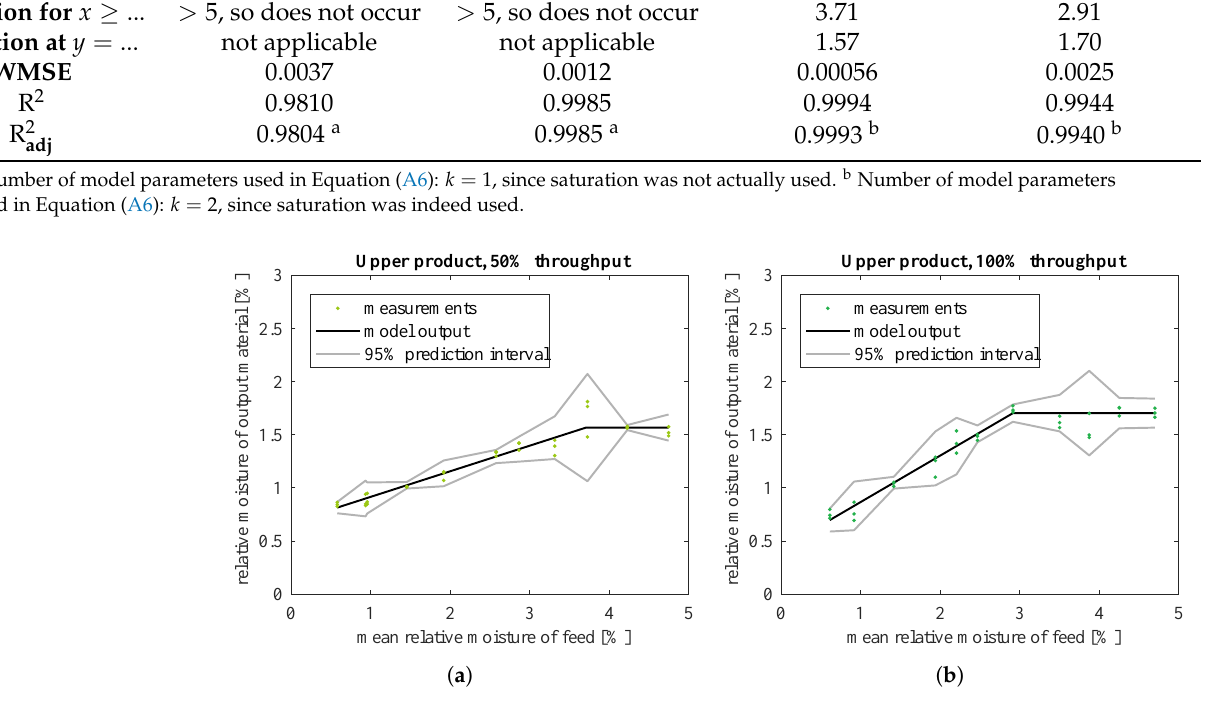
Figure 10. Straight lines with saturation fitted to measured moisture of upper classification product in relation to moisture of input material, separately for: ( a ) 50%, ( b ) 100% of nominal throughput of the screw feeder. Data for lower product are not plotted as they are identical to Figure 8a,b.